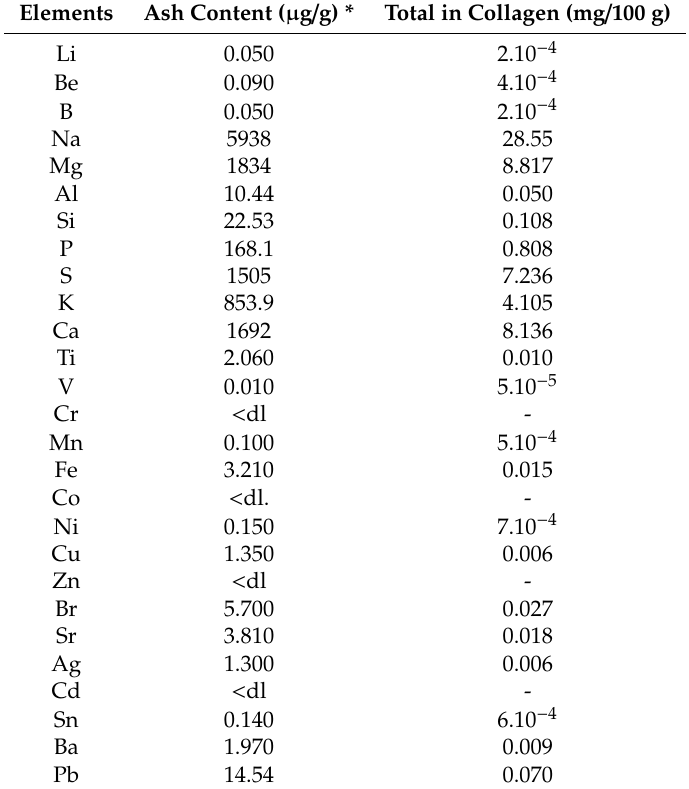
Table 8. Results of ICP-MS analysis on powdered collagen from chicken